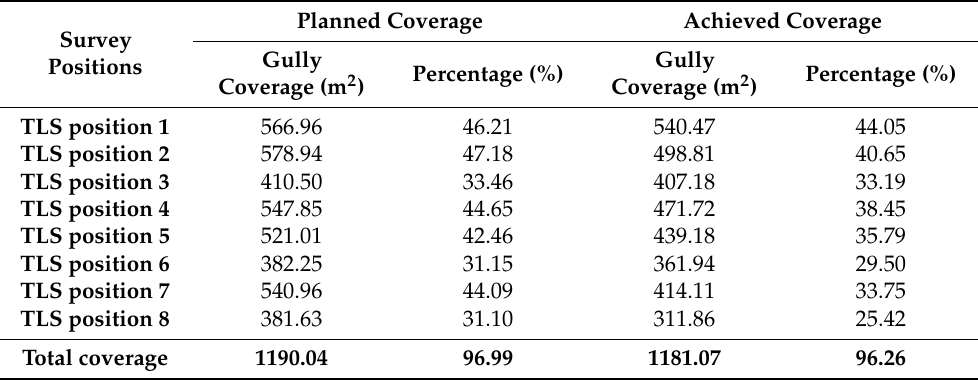
Table 2. Difference in total planned and achieved coverage for TLS survey 2019 over whole gully (SA-1).